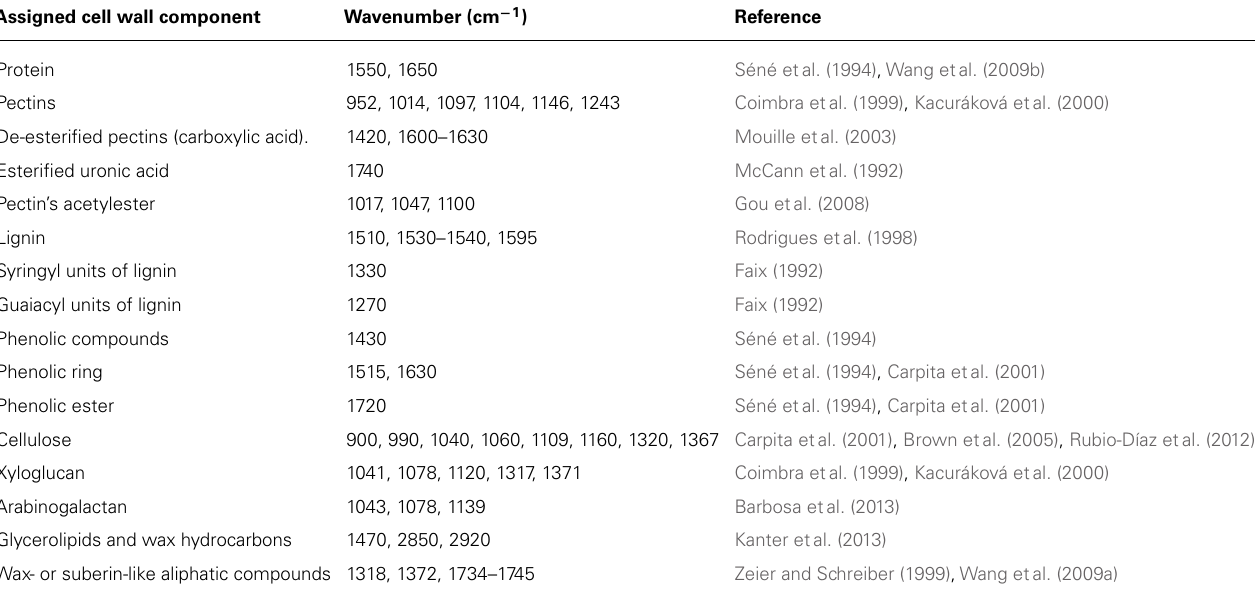
Table 1 |A summary of assignment of wave numbers obtained by FT-MIR spectroscopy to main cell wall components. Assigned cell wall